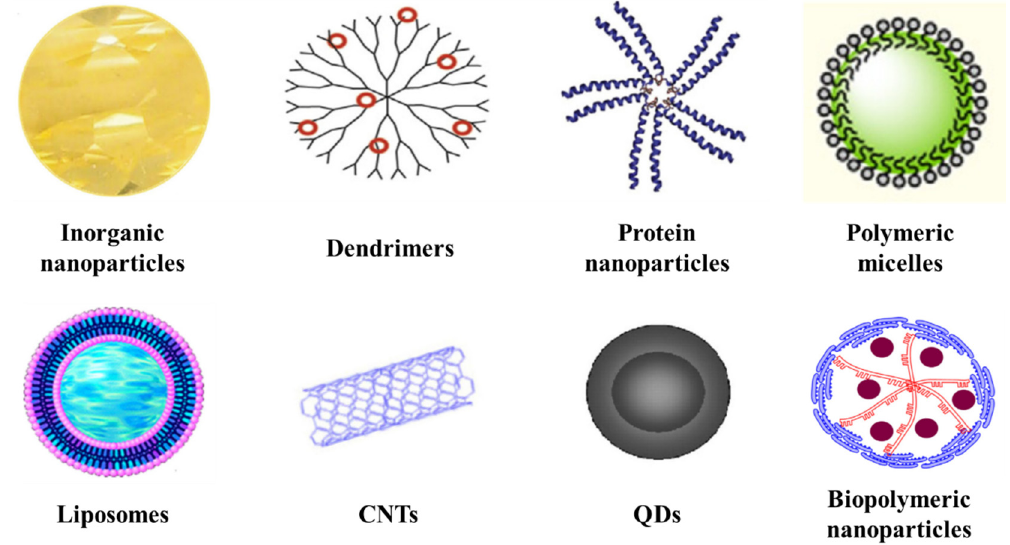
Figure 2. Examples of different nanoparticle drug delivery systems: inorganic nanoparticles, dendrimers, protein nanoparticles, polymeric micelles, liposomes, CNTs, QDs and biopolymeric nanoparticles.